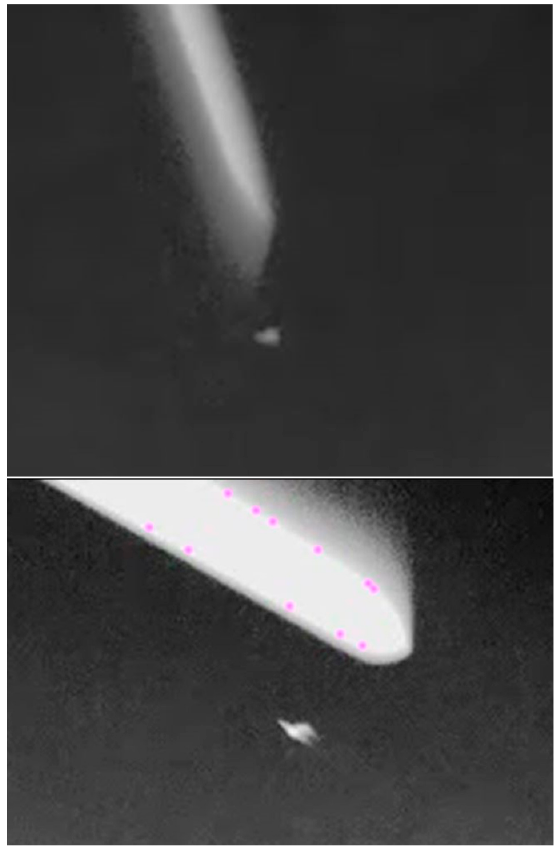
Figure 4. Examples of near misses of bats and moving wind turbine blades.